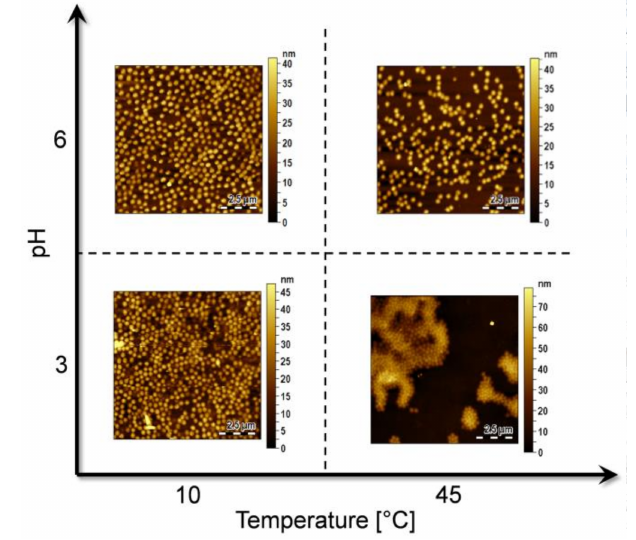
Figure 3. MGs films realized on the optical fibers tip by exploiting the effect of temperature and pH, keeping fixed the concentration at 0.5%. For each couple of temperature and pH an area of 10 × 10 µ m above the fiber core region is